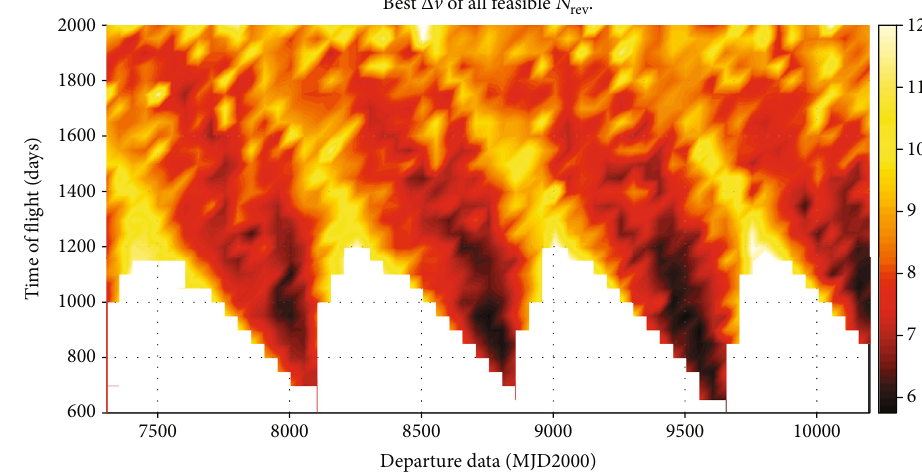
Figure 4: Launch window analysis in the Earth-Mars transfer mission.